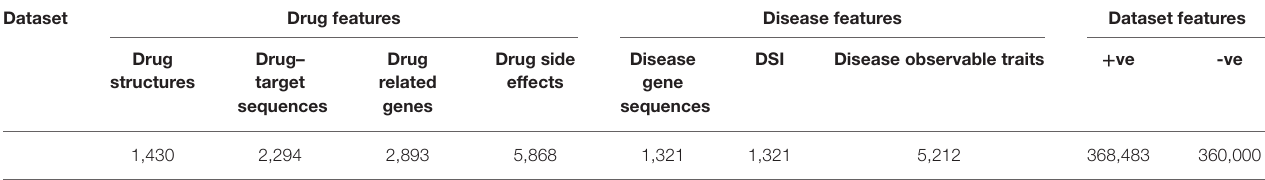
TABLE 1 | Drug and disease features in the dataset